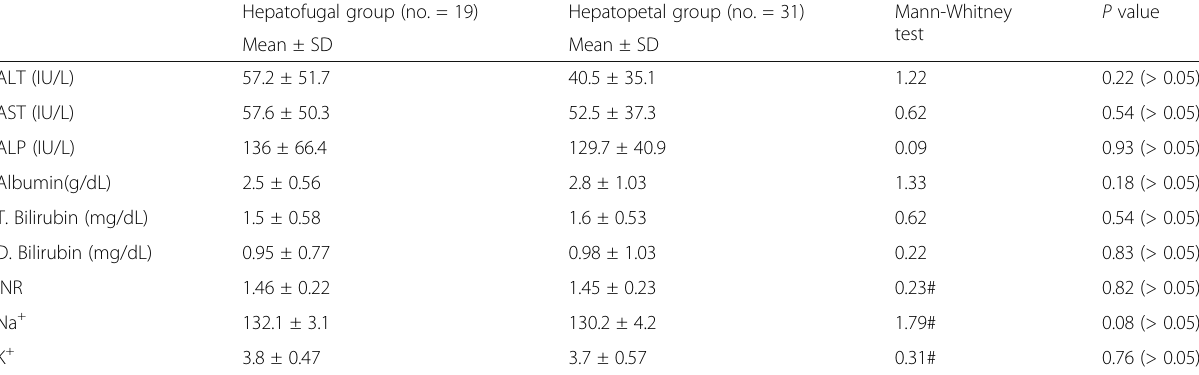
Table 5 Comparison between the studied groups regarding liver functions before TIPS Hepatofugal group (no. =